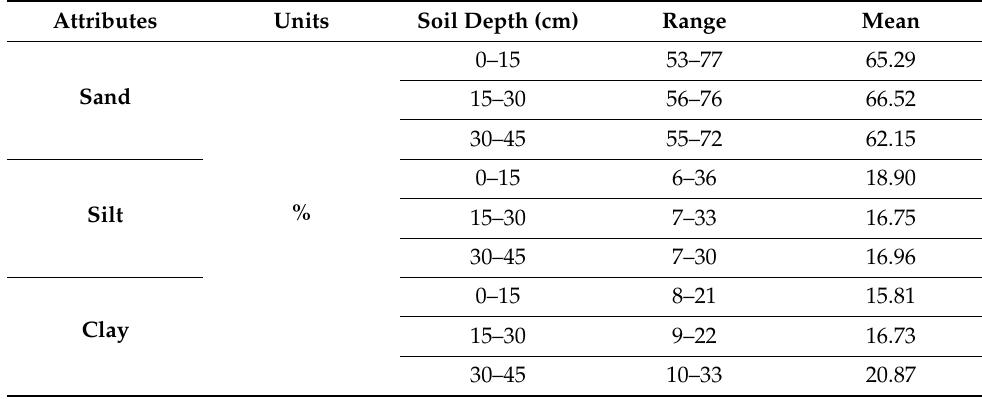
Table 1. Summary of selected sand, silt and clay contents of soils of citrus orchards in Layyah district. There were 48 sites at which sampling was performed. Means are an average of 3